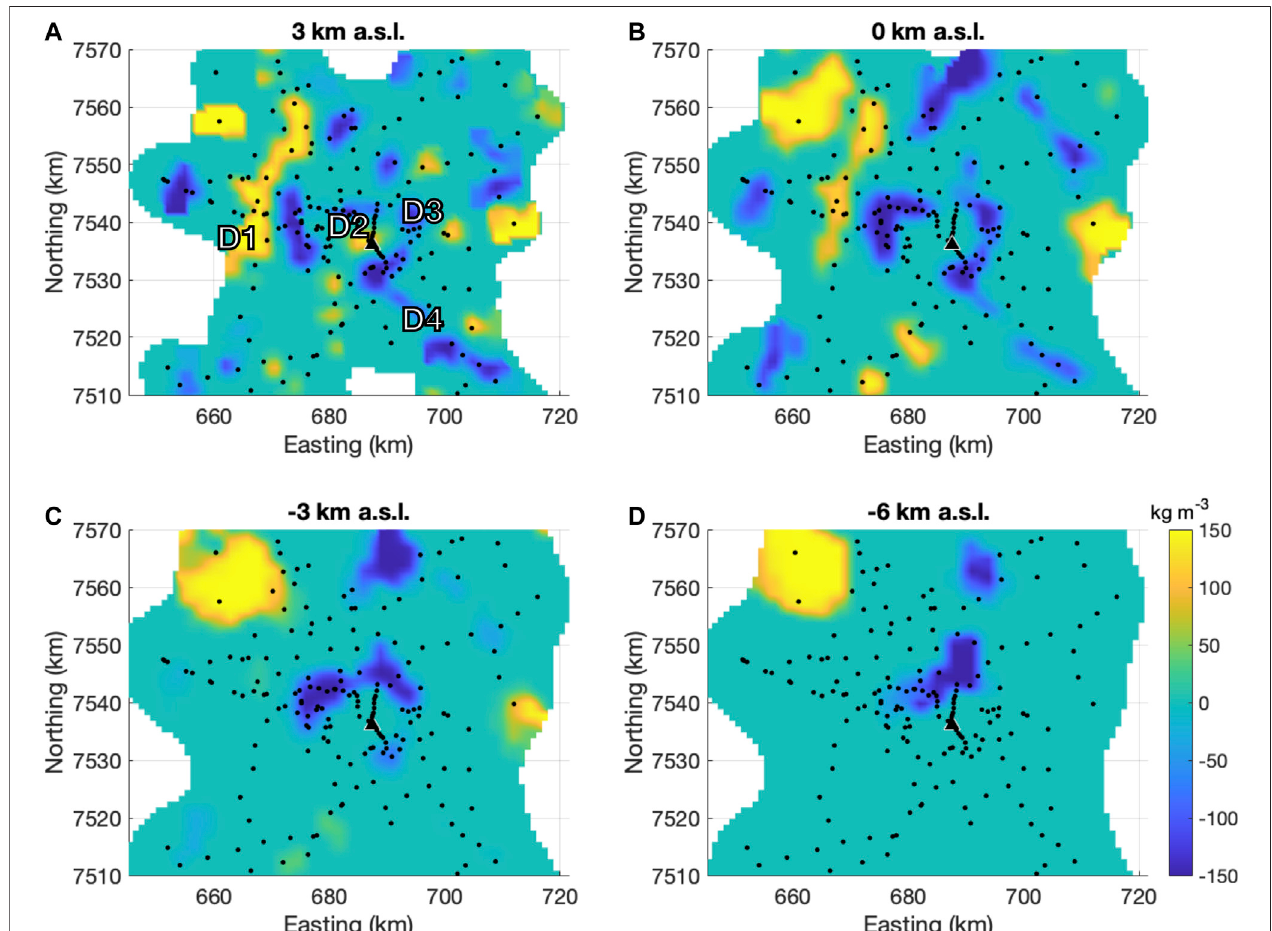
FIGURE 5 | Depth slices of the middle density model. Depths are in km above sea level (a.s.l.). Black triangle marks the location of Uturuncu, and black dots are gravity measurement locations used in the inversion.